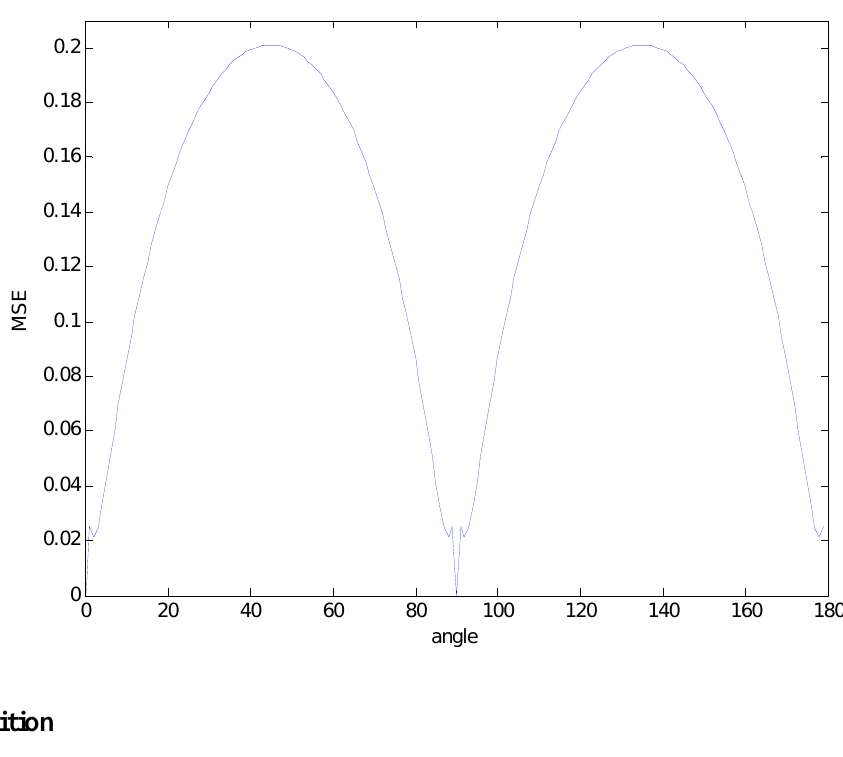
Figure 7. MSE for different rotation angles.